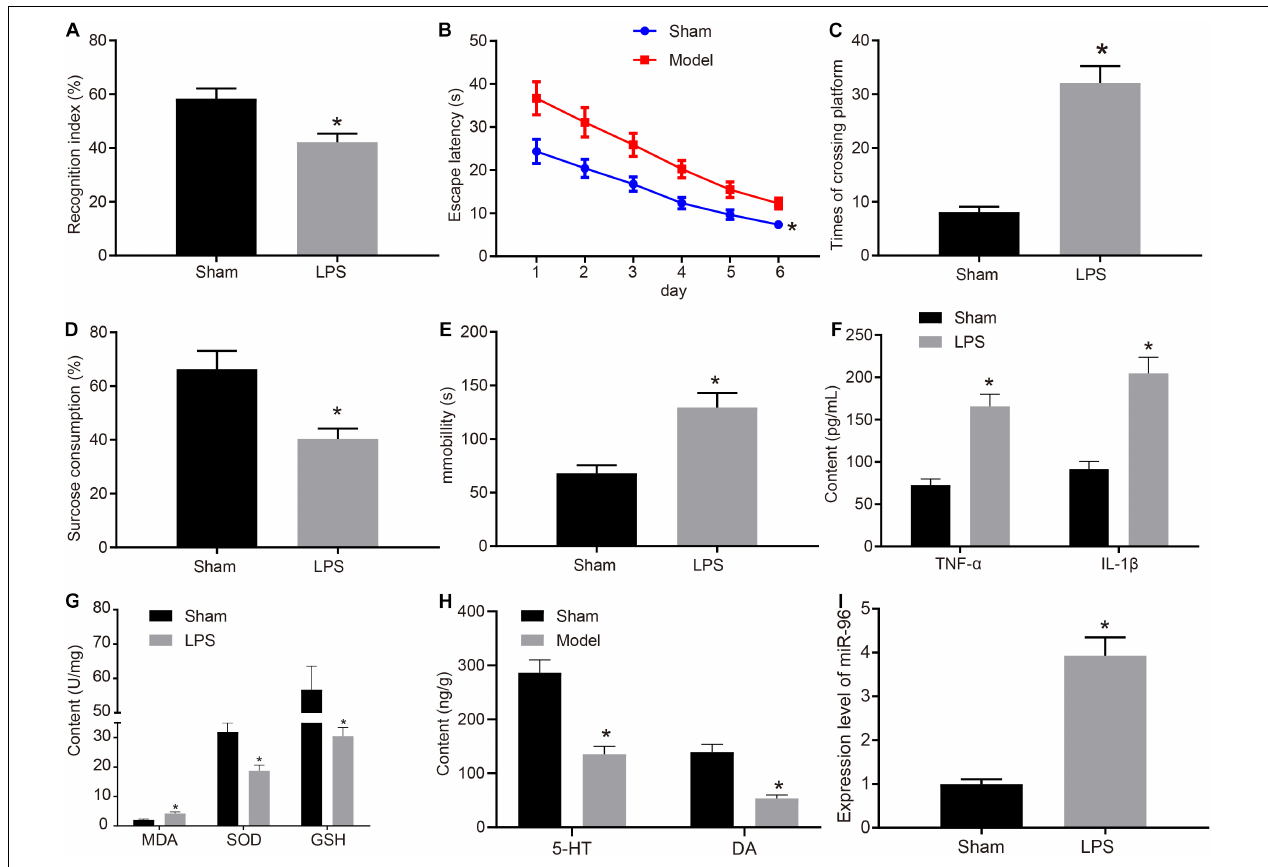
FIGURE 1 | miR-96 was highly expressed in CA1 region of brain in mice with depression-like behavior and memory impairment. (A) NORT index of mice after LPS induction, N = 10, t (18) = 10.38. (B) Escape latency of mice after LPS induction in Morris water maze experiment, N = 10, F (5,108) = 7.897. (C) Frequency of crossing platform of mice after LPS induction in Morris water maze experiment, N = 10, t (18) = 15.14. (D) Statistical results of sucrose preference experiment of mice after LPS induction, N = 10, t (18) = 10.50. (E) Immobility time of mice after LPS induction in forced swimming experiment, N = 10, t (18) = 12.56. (F) Levels of inflammatory factors TNF- α and IL-1 β in CA1 region of brain of mice after LPS induction measured by ELISA [ N = 10, t TNF − α (18) = 18.34, t IL − 1 β (12.86) = 17.20]. (G) Levels of MDA, SOD, and GSH in brain of mice after LPS induction, [ N = 10, t MDA (18) = 13.04, t SOD (18) = 11.24, t GSH (12.27) = 11.18]. (H) Levels of 5-HY and DA in brain CA1 region after LPS induction [ N = 10, t 5 − HY (18) = 17.27, t DA (11.91) = 17.25]. (I) RT-qPCR detection of miR-96 expression in mouse CA1 region after LPS induction, N = 10, t (10.04) = 21.29. * p < 0.05 vs. sham-operated mice. Measurement data were expressed as mean ± standard deviation. If data were in compliance with normal distribution and homogeneity of variance, unmatched data between two groups were analyzed using an unpaired t -test. Statistical analysis in relation to time-based measurements within each group was realized using repeated-measures ANOVA, followed by Bonferroni’s post hoc test. Cell experiment was independently repeated three times.